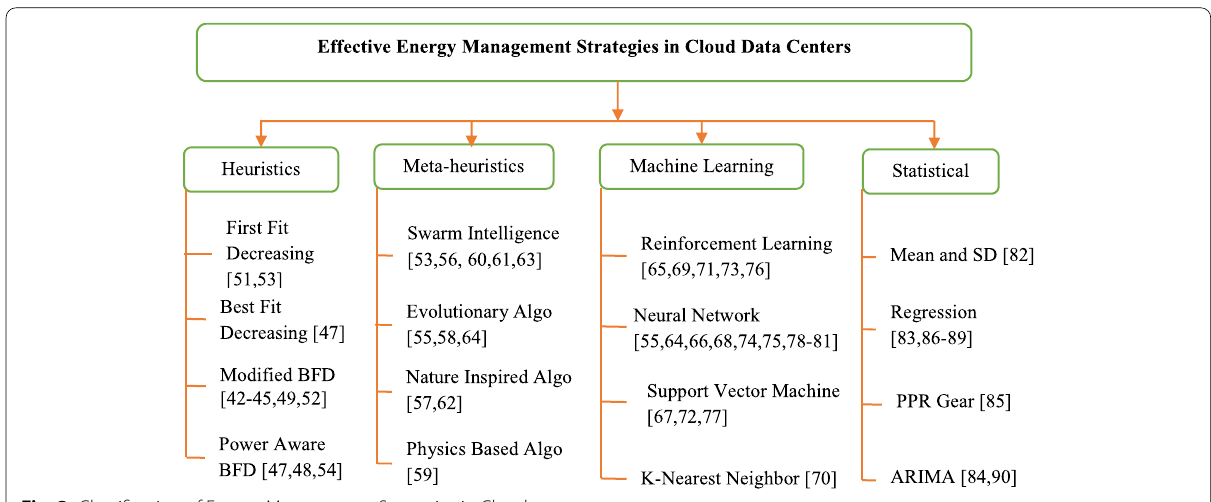
Fig. 3 Classification of Energy Management Strategies in Cloud